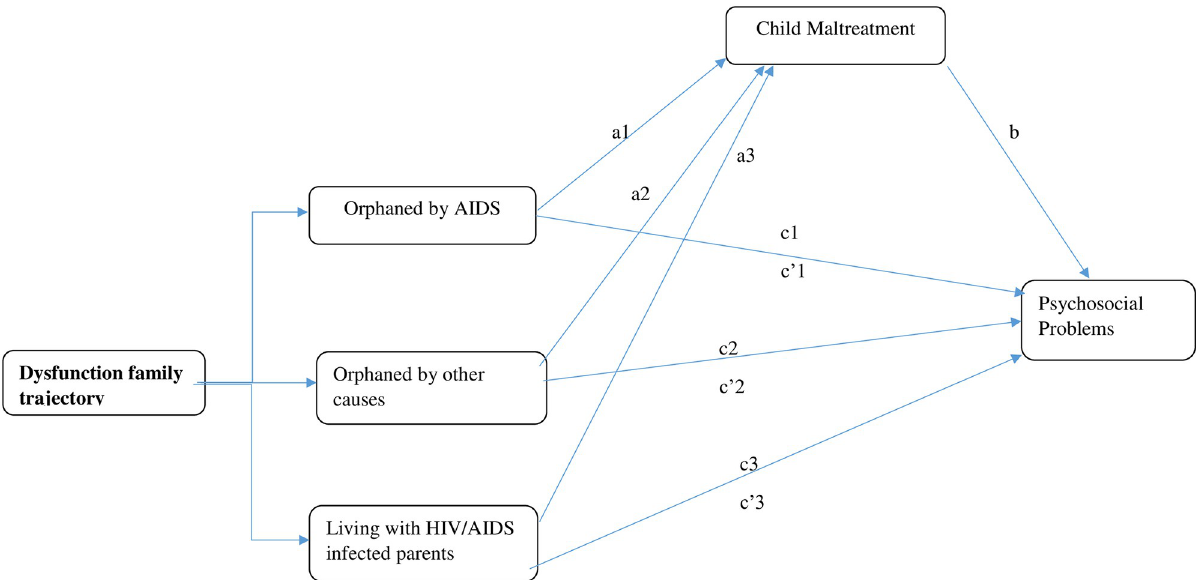
Fig 1. Hypothesized model. A mediation model of association between HIV/AIDS family dysfunction trajectories and psychosocial problems through child maltreatment. a 1, a 2, and a 3 = the relative effects of orphanhood by AIDS, orphanhood by other causes, and living with HIV/AIDS infected parents, respectively, relative to the intact family group, on child abuse. b = the association between child maltreatment and psychosocial problems after controlling for covariates. c 1, c 2, and c 3 = relative total effects of orphanhood by AIDS, orphanhood by other causes, and living with HIV/AIDS infected parents, respectively, relative to the intact family group, on child maltreatment after controlling for covariates. c’ 1, c’ 2, and c’ 3 = relative direct effects orphanhood by AIDS, orphanhood by other causes, and living with HIV/AIDS infected parents/caregiver, respectively, relative to the intact family group, on child maltreatment after controlling for relevant